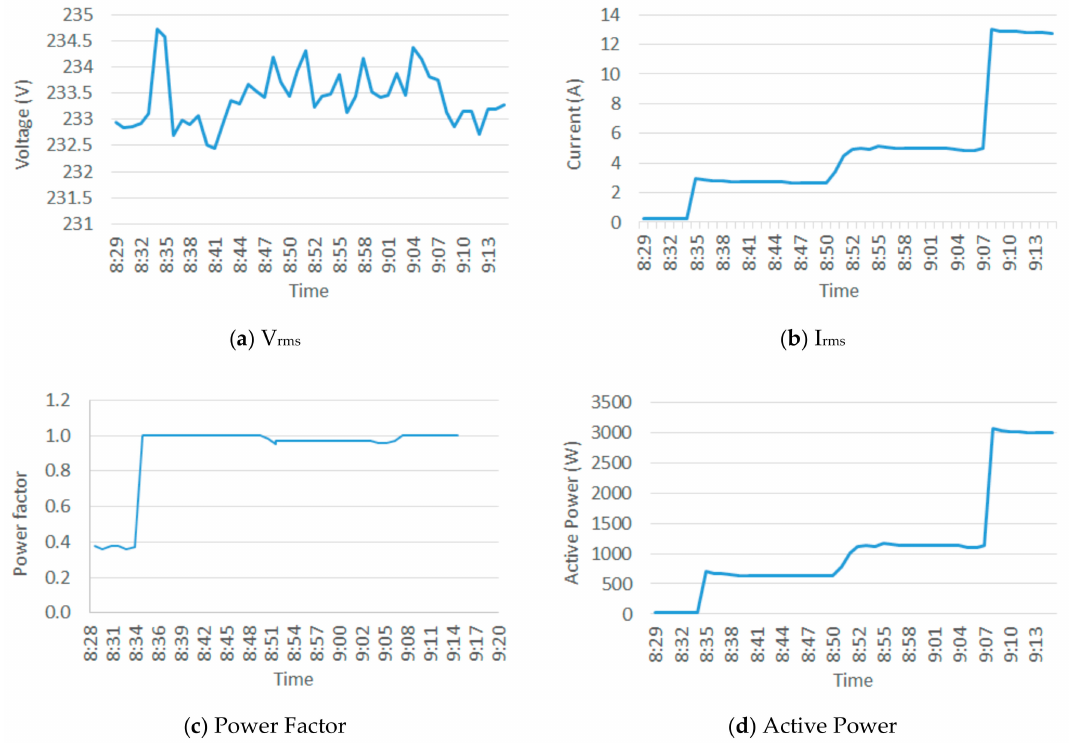
Figure 7. Kitchen energy information is shown through the ThingSpeak